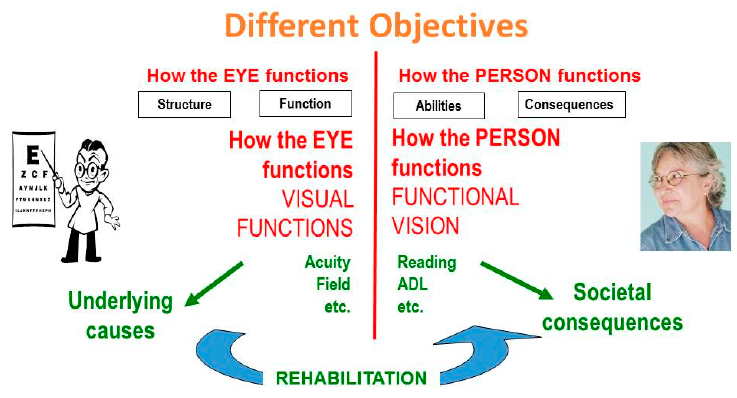
Figure 2. The role of rehabilitation.